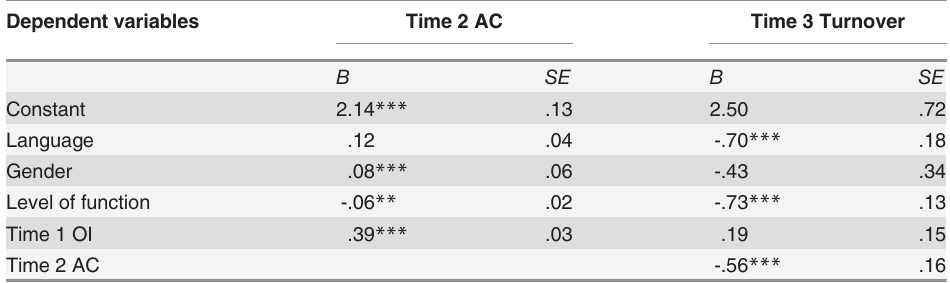
Table 5. Study 3: Logistic Regression